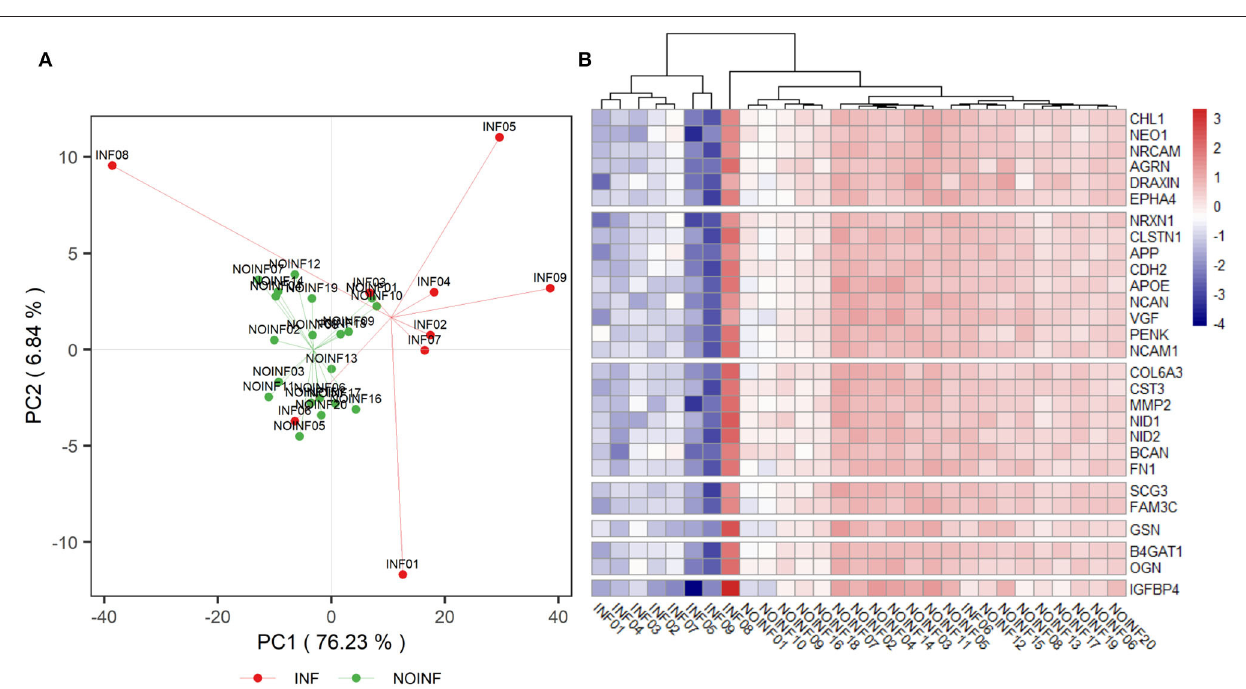
FIGURE 1 | PCA score plot of detected proteins (A) and a heatmap of proteins listed in Table 2 (B) . A trend of separation between the NOINF and INF groups and a large variation in the INF group were observed in the PCA score plot. All proteins listed in Table 2 were plotted in the heatmap based on the z -scores of their logarithm-transformed abundance and all patients were clustered with Hierarchical Clustering based on Euclidian distance.